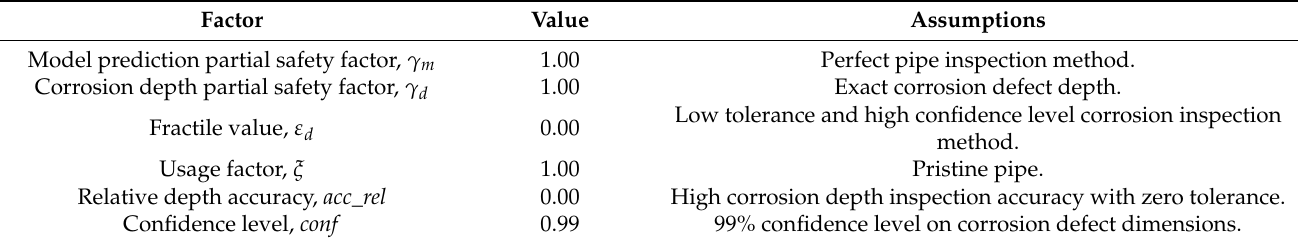
Table 3. DNV corrosion assessment factors and assumptions.